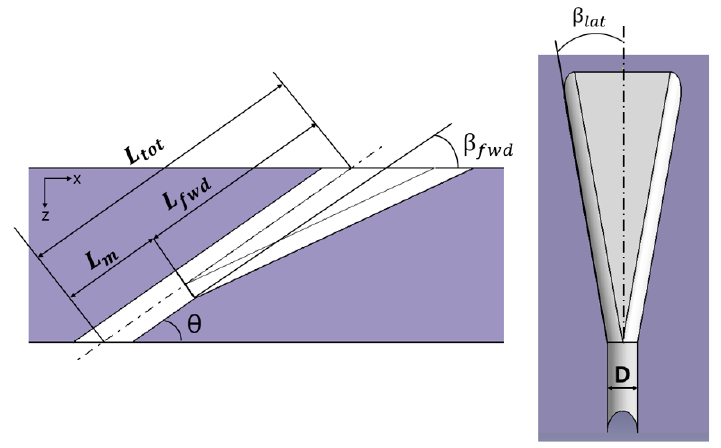
Figure 2. Geometry of fan-shaped hole. Energies 2020 , 13 , x FOR PEER REVIEW